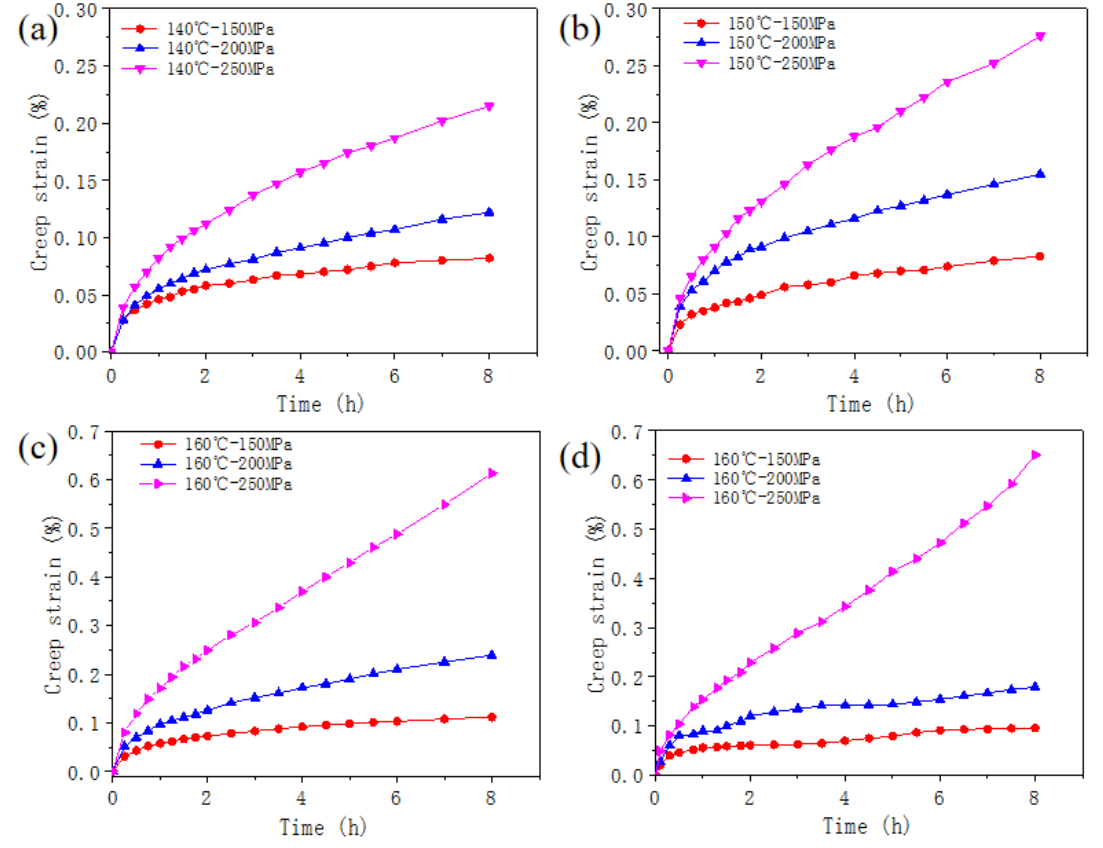
Figure 2. Creep curves under different applied tensile stress for 8 h; ( a ) at 140 ◦ C; ( b ) at 150 ◦ C; ( c ) at 160 ◦ C; ( d ) at 160 ◦ C of 7B04-T7451 al alloy. A temperature-compensated power law creep equation for minimum strain rate given by [30,31]